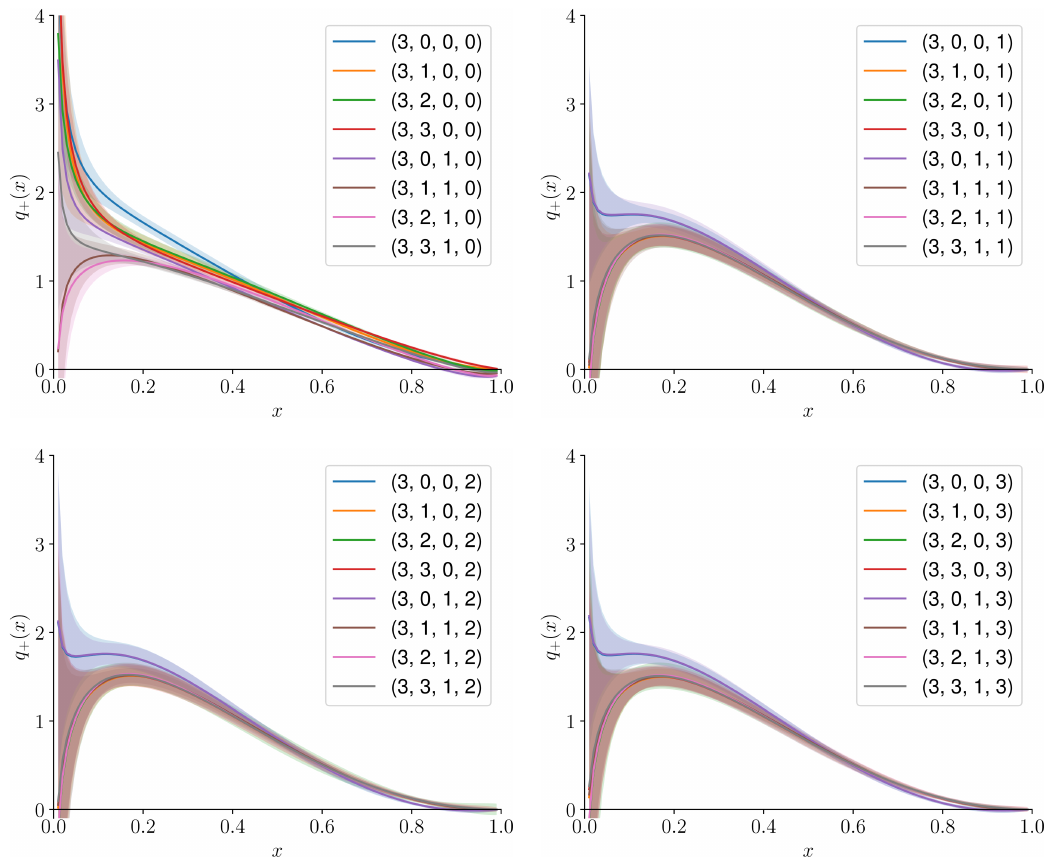
Figure 18 . The PDF results from fitting the imaginary component to the models. The numbers in the legend correspond to ( N ± , N